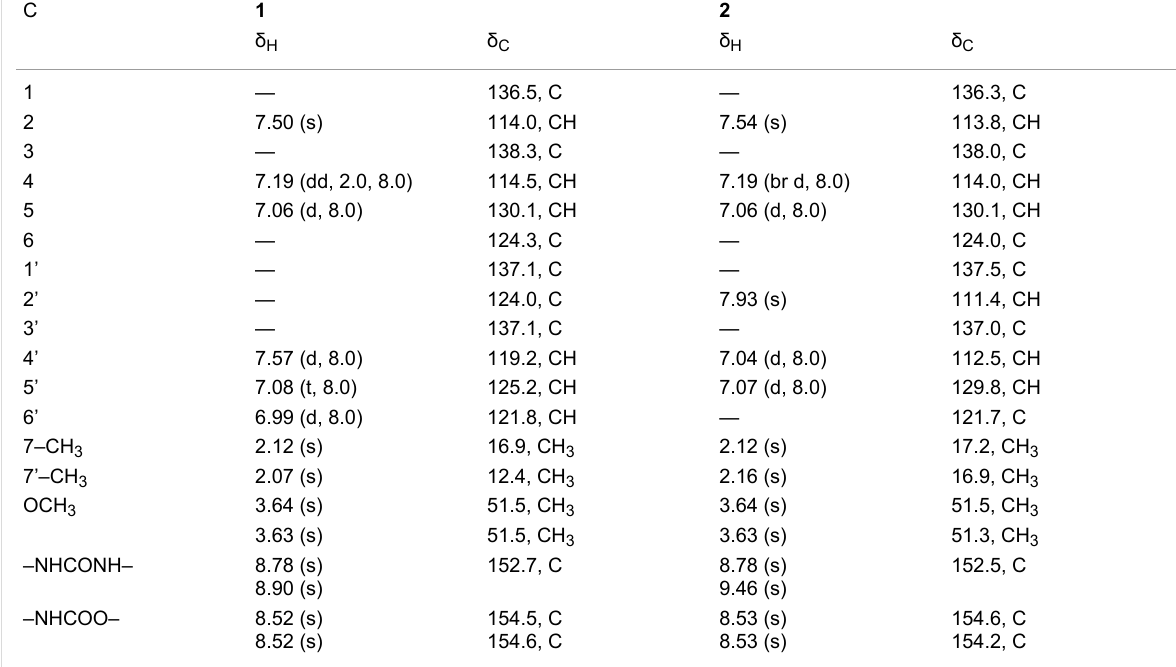
Table 1: 1 H (500 MHz) and 13 C NMR (125 MHz) data of 1 and 2 (in DMSO- d 6 , δ in ppm, J in Hz).